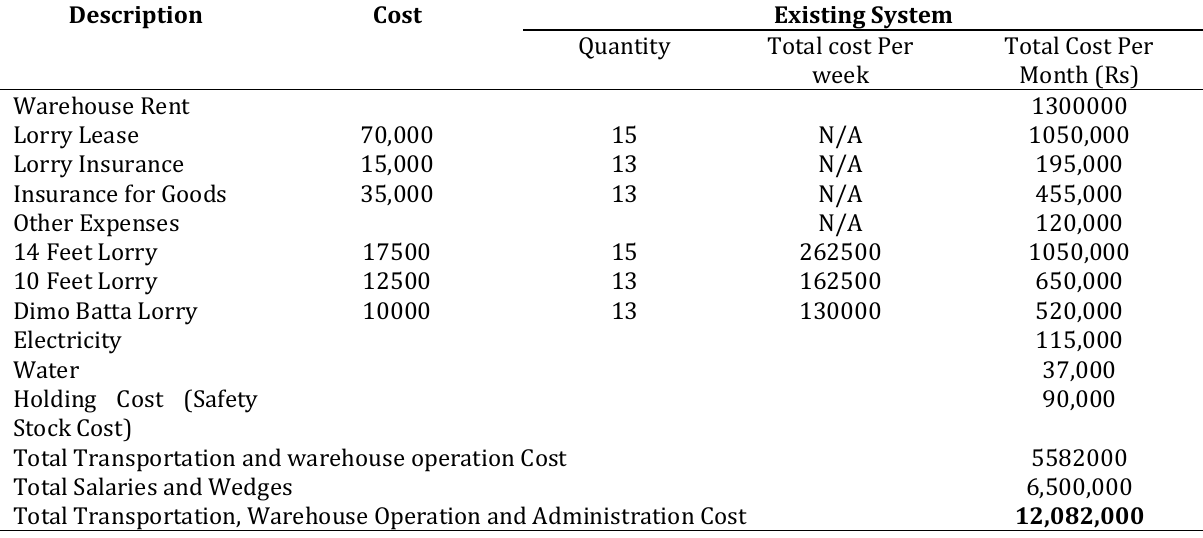
Table 10: Total transportation, warehouse operation and administration cost of the existing